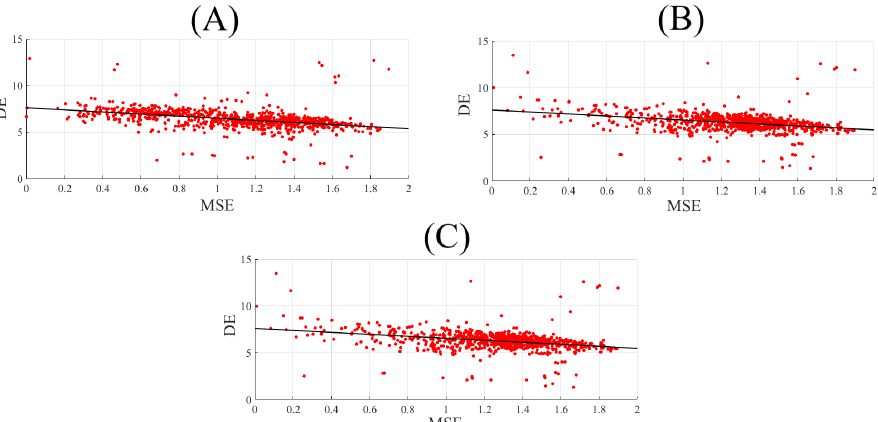
Figure 6. Spearman correlation between participants’ DEs (i.e., 62 DEs associated with 62 EEG channels of a participant, per affect) and their corresponding MSE20 values (i.e., 62 MSE20s associated with 62 EEG channels of a participant, per affect) in ( A ) negative, ( B ) neutral, and ( C ) positive.